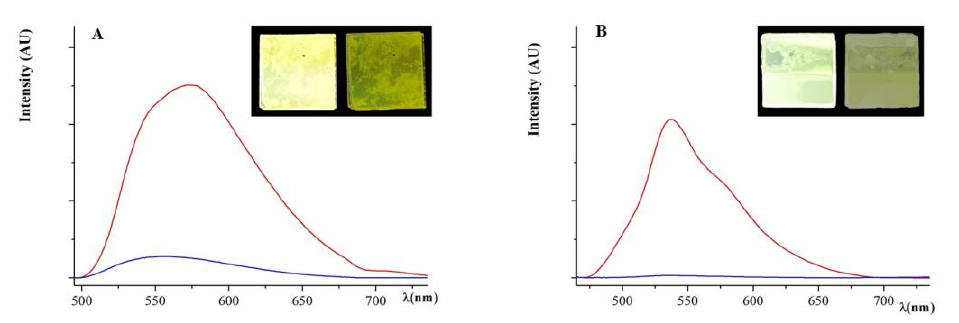
Figure 2. Fluorescence spectra recorded on 1% doped LC sample of C1b ( A ) and C2b ( B ) before (red curve) and after isotropization (blue curve). Inset: the same sample deposed between quartz slides under 365 nm UV light before ( left ) and after ( right ) isotropization.